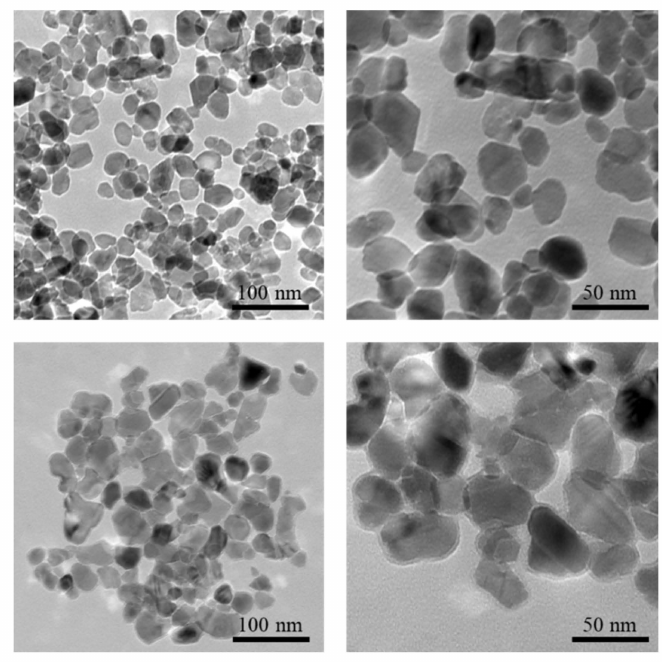
Figure 2. Transmission electron microscopy (TEM) image of ZnO. Top (without NOM), down (with